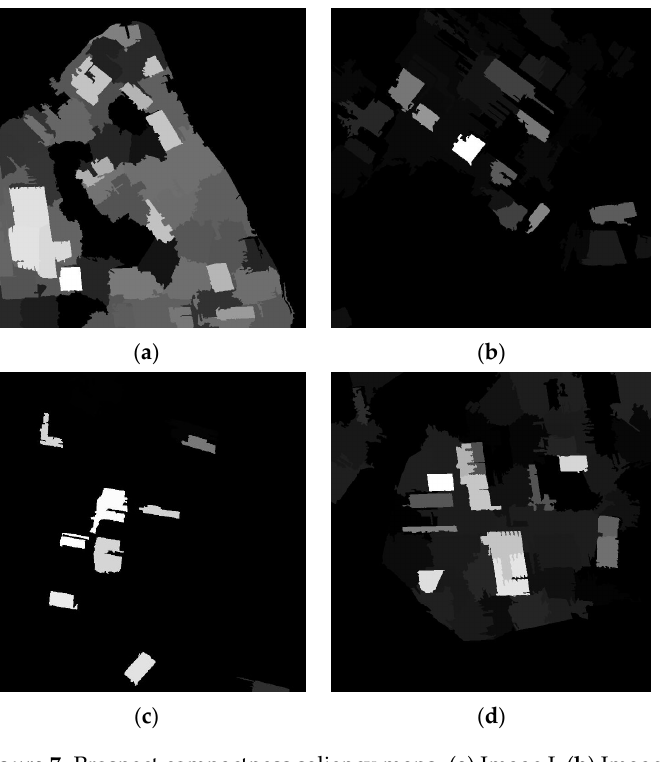
Figure 7. Prospect compactness saliency maps. ( a ) Image I, ( b ) Image II, ( c ) Image III, ( d ) Image IV.